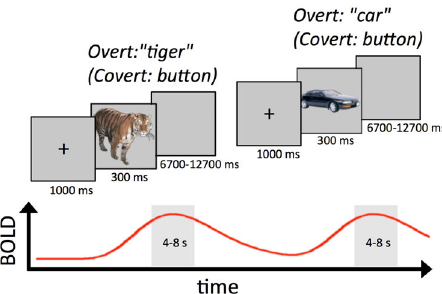
Fig. 2 Overt and covert picture naming tasks. Participants were instructed to name pictures out loud (Overt Naming) or silently to themselves, pressing a button to mark the naming time (Covert Naming). Trials were structured in a slow event-related design in order to separate the peak responses of individual trials, and jitter of 8 – 14 s occurred from trial onset to trial onset. Name responses were marked for correctness and the onset time of the voice/button response was recorded for each trial. For analyses of local activity, an empirical hemodynamic response function was estimated across trials with a separate regressor at each timepoint following stimulus onset. For connectivity analyses, the peak BOLD response was calculated for each trial and in each fMRI voxel by averaging the 2 timepoints (4 – 6 and 6 – 8 s) adjacent to the expected peak of the hemodynamic response function, with a single peak value saved for each trial in order to minimize the contribution of the temporal contour of the evoked responses from functional and effective connectivity